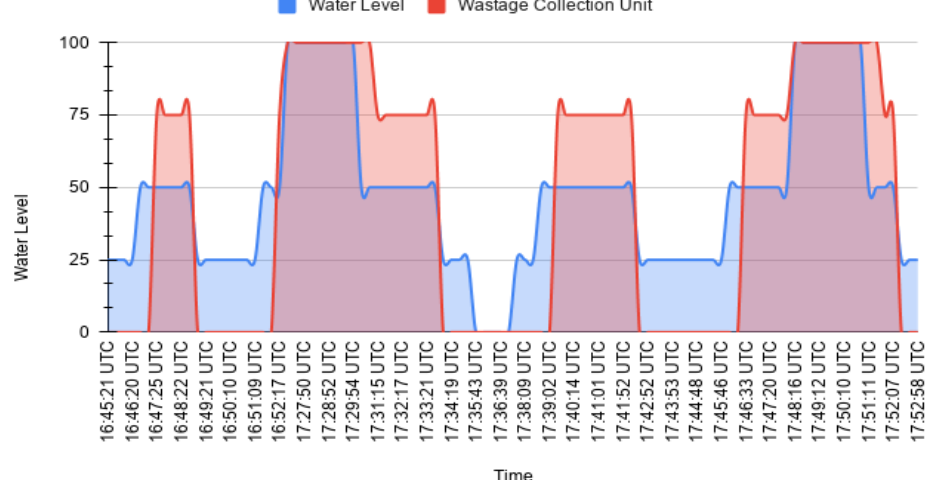
Figure 8. Visual presentation of the relationship between water level and the conveyor belt’s mo- tor speed.